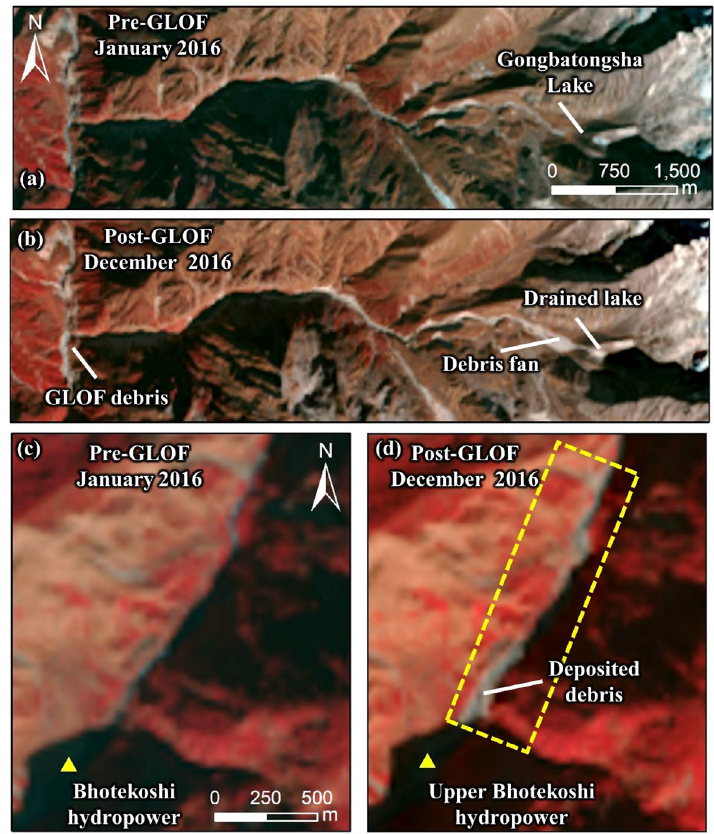
Figure 9. Pre-GLOF Landsat imagery acquired in January 2016 and post-GLOF imagery acquired in December 2016 showing the Gongbatongsha Lake, debris fan, and deposited debris. The satellite images were obtained from USGS Earth Explorer (URL: https:// earth explo rer. usgs. gov/). This map was created using ArcMap 10.8 software (© ESRI, URL: https:// www. esri. com/ en- us/ arcgis/ produ cts/